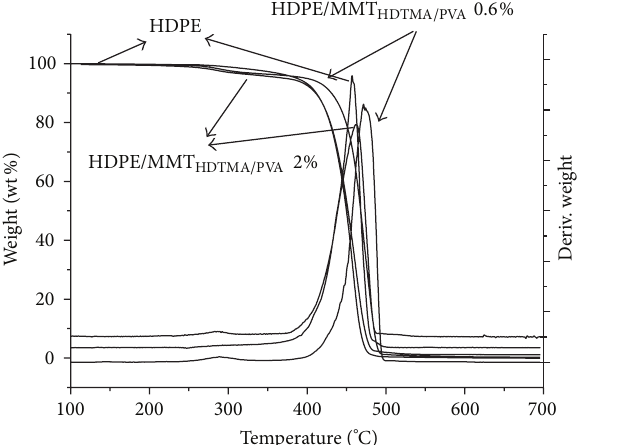
Figure 3: TEM images of HDPE/MMT (f)).